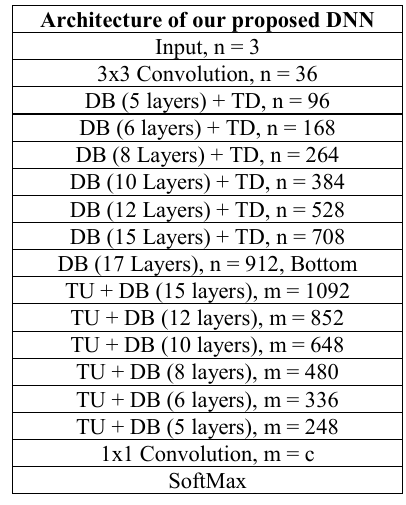
Table. 1 The Architecture of our proposed neural network